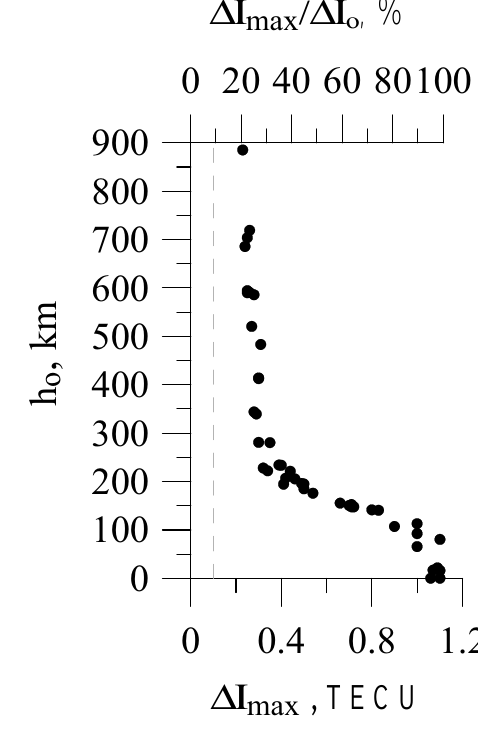
Fig. 5. Dependence of the absolute TEC increase 1I max on the shadow altitude h 0 during the solar flare of 14 July 2000. The dashed line on the plot corresponds to the root-mean-square de- viation of background oscillations in the absence of a flare. The upper scale shows the dependence of the relative TEC increase 1I max /1I 0 on the shadow altitude h 0 during the solar flare in per- cent. The TEC increase 1I 0 corresponds to the amplitude of the TEC increase measured at the station lying on the shadow bound- ary on the ground h 0 =